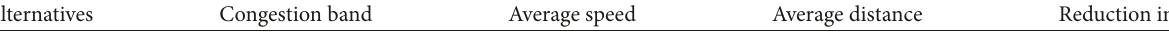
Table 2: Alternatives comparative (travel time).